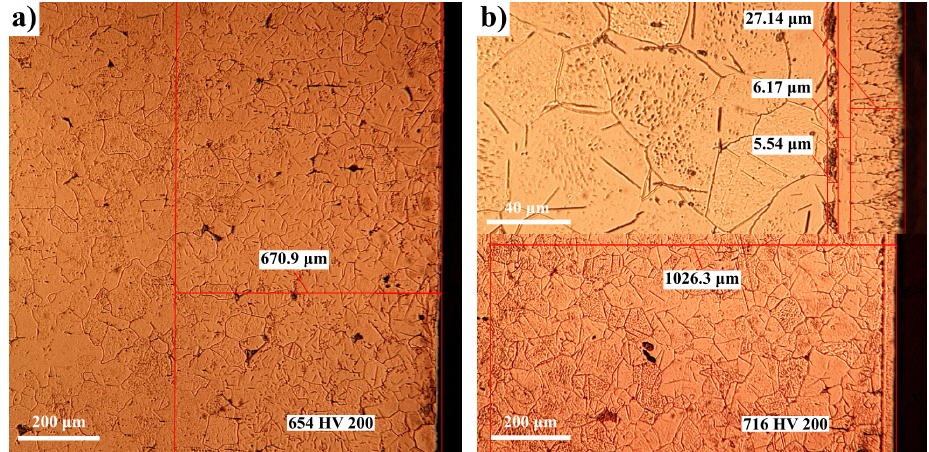
Figure 5. OM of the nitrided Fe-ARMCO at different temperatures: 540 °C ( a ) and 620 °C ( b ) within atmosphere of partially dissociated ammonia, α NH3 = 45%, diluted with nitrogen into 60% ratio; N 2 potential 1.9; ⁓ 8.3% N 2 ( a ) and ⁓ 8.9% N 2 ( b ) at the surface layers. The microhardness indentations were performed at 150 microns from the surface of the layer. By nitriding 34CrAlMo5 nitralloy steel, totally different results are obtained in terms